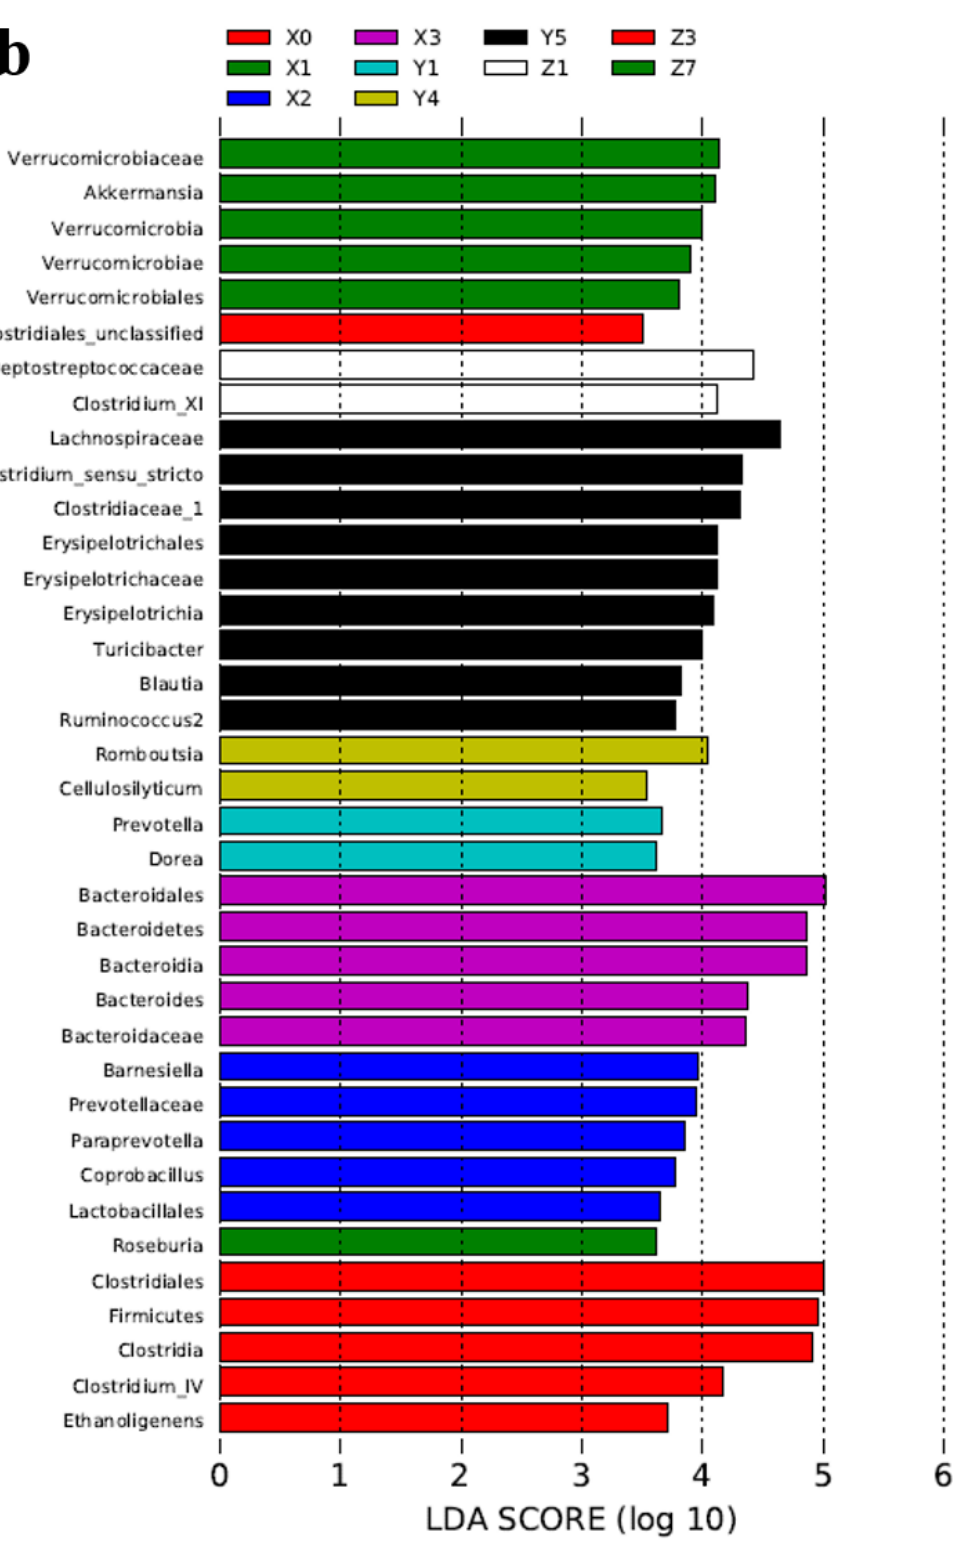
Figure 3. Alterations in bacterial genera abundance in the feces at different periods. ( a ) Selected genera belonging to a different phylum with significantly different abundances in the feces. ( b ) Lefse analysis histogram; different colors represent different groups. The horizontal axis is the LDA score obtained after LDA analysis, and the vertical axis is the group of microorganisms with significant effects.